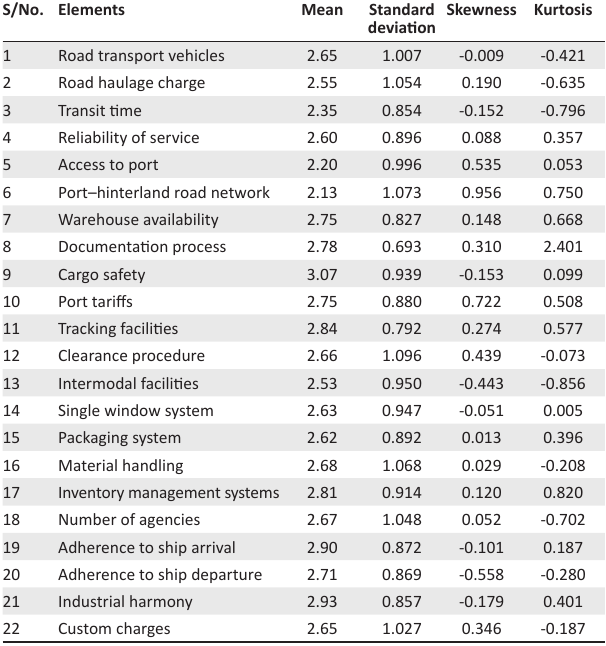
TABLE 2: Descriptive statistics of trade logistics and supply chain contribution to international trade. S/No.